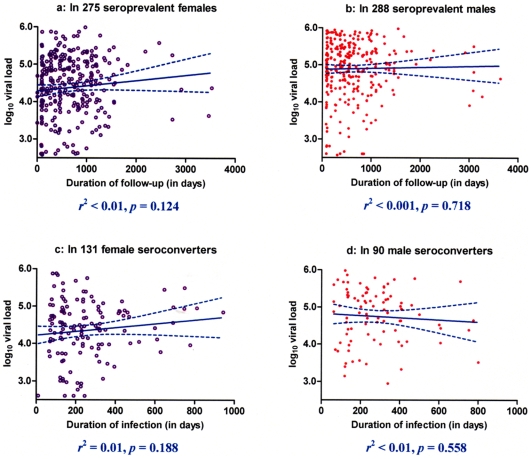
Distribution of HIV-1 viral load (VL) in the study population, with stratification by sex and serostatus at enrollment.There is no linear correlation between duration of follow-up and log10 VL in seroprevalent Zambians (p≥0.12) or duration of infection and log10 VL in seroconverters (p≥0.56). In each panel, the projected slope and its 95% confidence interval are shown in solid and dotted lines, respectively.